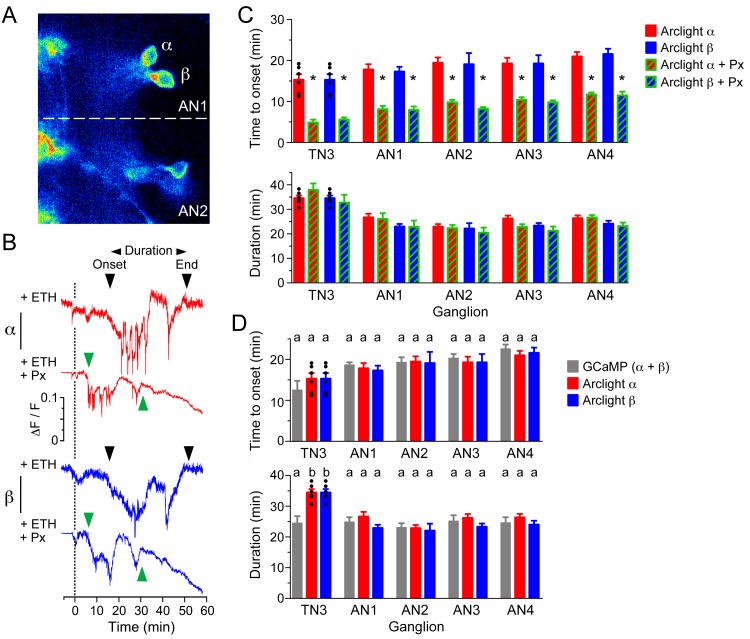
GABA delays depolarization of CCAP neurons induced by ETH.(A) ArcLight fluorescence in CCAP neurons α and β from ganglion AN1-2. (B) ArcLight signal recorded from α (red trace) and β (blue trace) neurons following ETH stimulation in control CNS (+ETH; top traces) and in the presence of picrotoxin (+ETH+Px, lower traces). Zero min indicates time of ETH challenge. Inverted triangles indicate start and end of depolarization; 'Duration' corresponds to the time between these two events. (C) Quantitation of results showing time of onset of depolarization (top) and duration of depolarization (bottom) in CCAP neurons from TN3 and AN1-4 (neurons in AN8 and AN9 could not be visualized). (D) Comparison between timecourse of GCaMP and ArcLight signal. Data in (C,D) are mean ± SEM. N = 10–13 for all genotypes. In (C), statistically significant differences (p<0.05) relative to control are indicated with '*'; t test (unpaired, two-tailed). In (D), statistically significant differences (p<0.05) are indicated by different letters; one-way ANOVA, Tukey's post-hoc multiple comparison analyses. Actual p values for all analyses can be found in Supplementary file 1. Individual measurements have been superimposed on the summary histogram when <8 neurons showed a measurable response. Genotype of animals expressing ArcLight sensor: CCAP>Arclight; of those expressing GCaMP: CCAP>GCaMP.